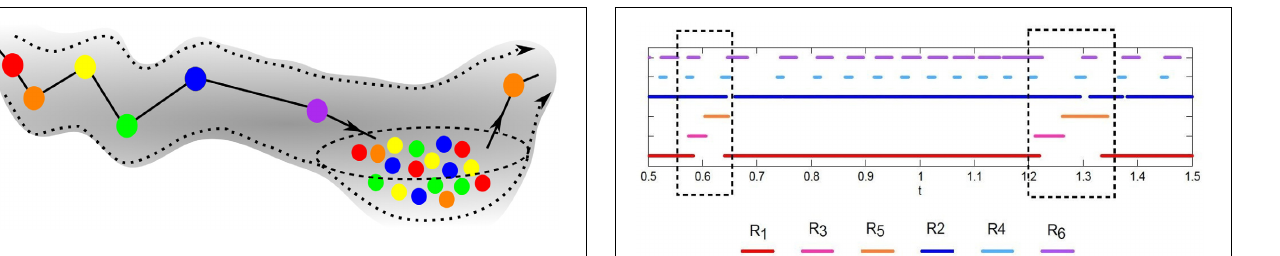
FIGURE 8 | Raster plot of intermittent sequences of the variables of the GLV system in the case of heteroclinic chimera dynamics; the 6 variables are shown as R 1 , R 2 , R 3 , R 4 , R 5 , and R 6 , respectively. A given variable is shown in the plot if its amplitude exceeds a threshold value; the threshold used here is 0.1. Note the preservation of sequential switching in the boxes marked by dashed